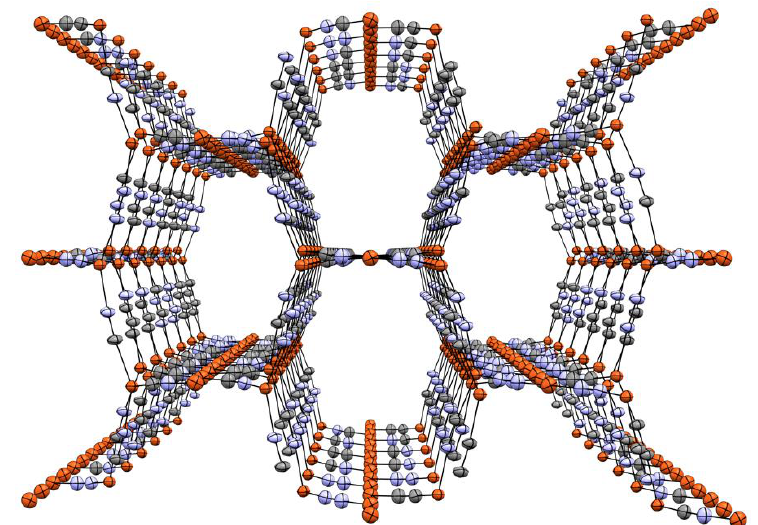
Figure 2. Thermal ellipsoid (40% probability) packing diagram of 2 at 295 K along the c -axis, showing stacked elongated {CuCN} 8 hexagons. Me 4 N + cations omitted for clarity. Cu orange, N blue, C grey.